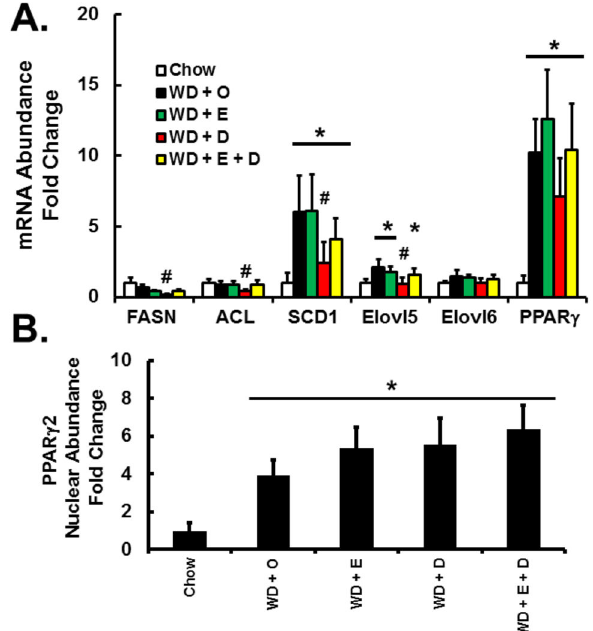
Figure 9. Diet effects on the expression of PPARγ2 and enzymes involved in MUFA synthesis. Panel A: Expression of enzymes involved in MUFA synthesis and the nuclear receptor peroxisome proliferator activated receptor γ2 (PPARγ2). Results are represented as mRNA Abundance-Fold Change, relative to chow-fed mice; mean ± SD, n=8/group. [Fatty acid synthase (FASN); ATP citrate lyase (ACL); stearoyl CoA desaturase 1 (SCD1), fatty acid elongase (Elovl)] Panel B: Hepatic nuclear abundance of PPARγ2 expressed as Fold ≤ 0.05 versus chow; #, P ≤ 0.05 versus WD + O.